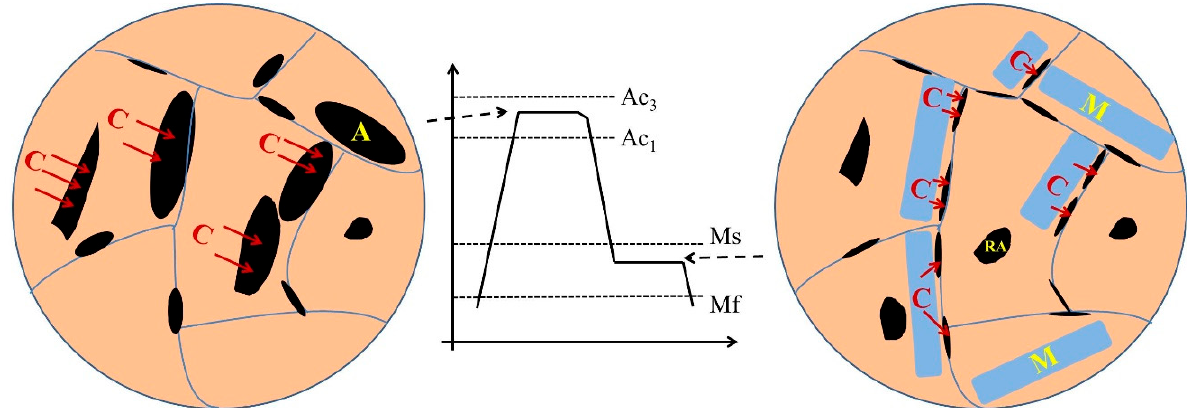
Figure 11. Schematic diagrams of microstructure evolution with residual austenite.